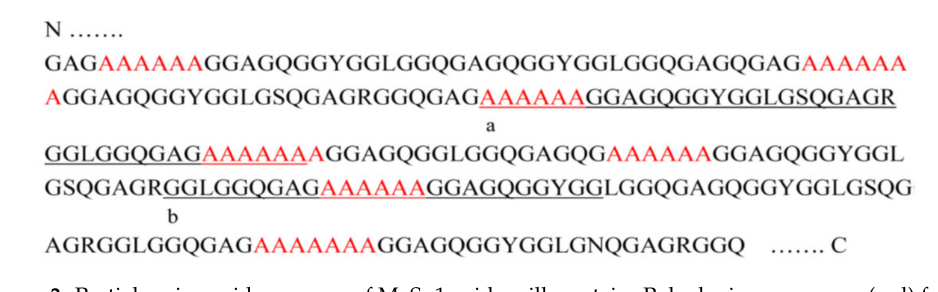
Figure 3. Partial amino acid sequence of MaSp1 spider silk protein. Polyalanine sequences (red) forms antiparallel β -sheet structure [4]. The underlined sequence, a, is the selected sequence to study the conformations of amino acid residues in the Gly-rich region sandwiched by poly-A sequence on both sides reported previously [46,60,62]. The underlined sequence, b, is selected to study the conformation and packing structure of poly-A sequence sandwiched by partial Gly-rich sequences [63].